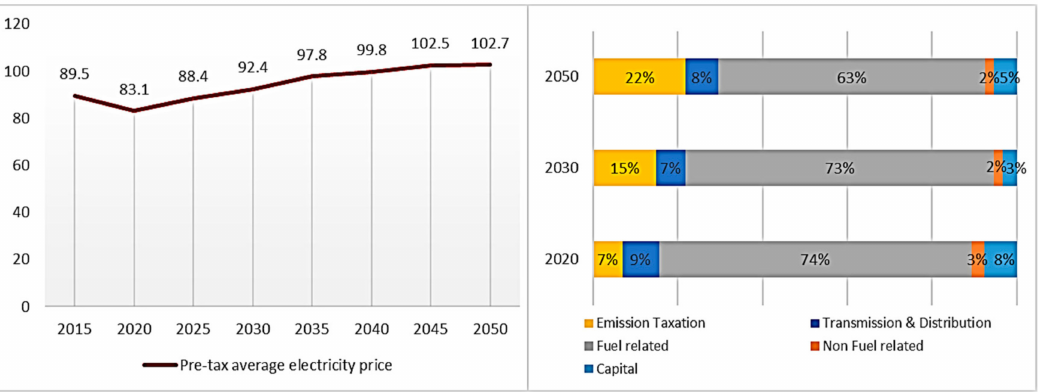
Figure 6. Baseline scenario—electricity tariff and its components in 2020–2050; source: